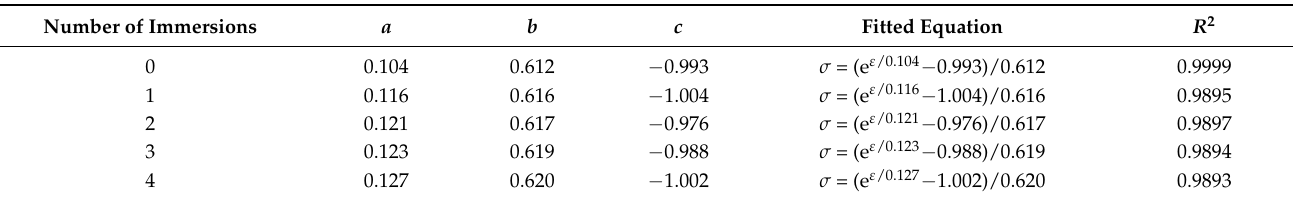
Table 3. Fitting parameters and equations of the stress and strain relationship of the gangue with different immersion times.